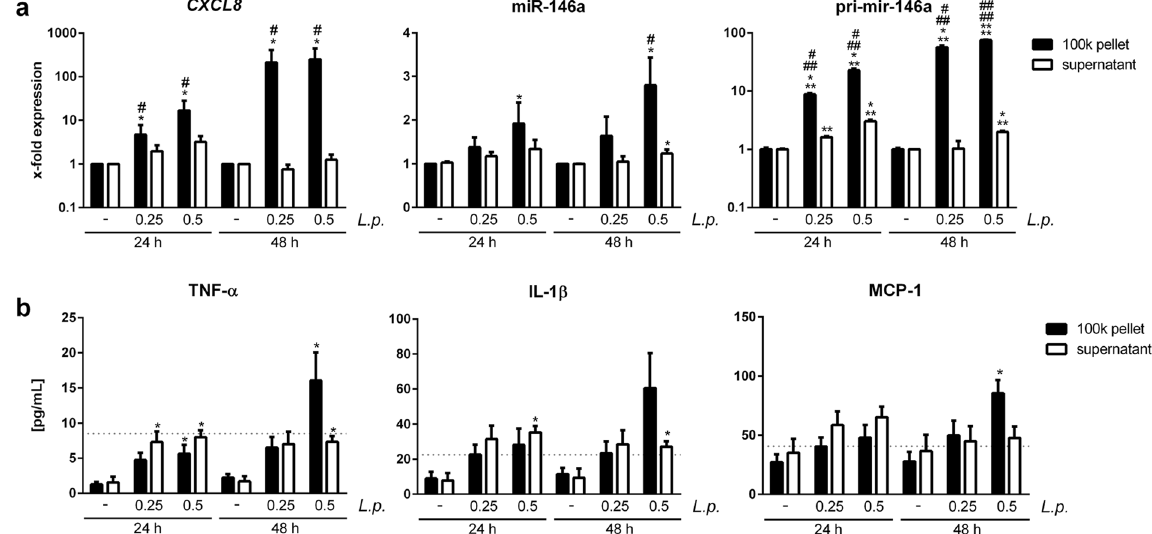
Figure 4. L . pneumophila induced EVs elicit a pro-inflammatory response in non-infected THP-1 cells. ( a , b ) Response of THP-1 cells to vesicle-free supernatant or 100 k pellet from L . pneumophila -infected THP-1 cells. THP-1 cells were stimulated with vesicle-free supernatant or 100 k pellet from THP-1 cells infected with L . pneumophila (MOI 0.25 and 0.5, respectively) for 24 h. Recipient THP-1 cells were incubated for 24 or 48 h, respectively. ( a ) qPCR was performed for expression of CXCL8 , miR-146a and pri-mir-146a. ( b ) Magnetic multiplex ELISA was performed. Results for TNF- α , IL-1 β and MCP-1 are shown. Dashed lines indicate the input of the cytokine contained in the vesicle-free supernatant of infected THP-1 cells (MOI 0.5) before adding it to the recipient cells. Data are shown as mean + SEM of at least three independent experiments. * p < 0.05. * Compared to corresponding control, # compared to corresponding supernatant treated